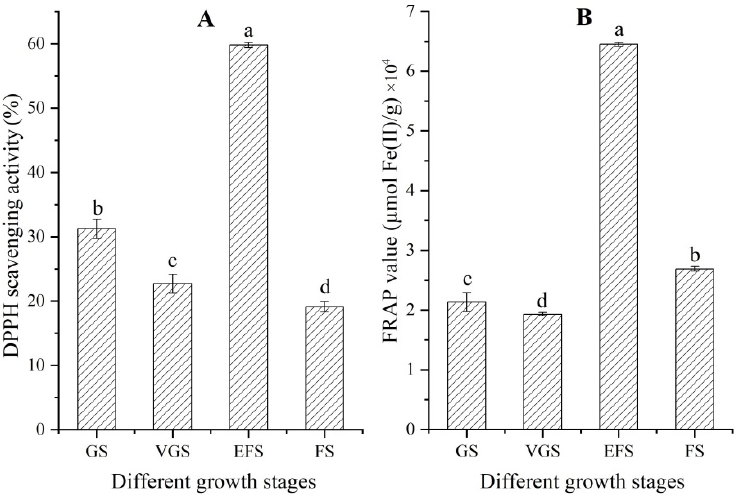
Figure 3. DPPH scavenging activity and FRAP value of extracts from stems of C. songaricum at four different growth stages (mean ± SD, n = 3). Images ( A , B ) represent DPPH scavenging activity and FRAP value, respectively. Different letters represent a significant difference ( p < 0.05) at different growth stages.